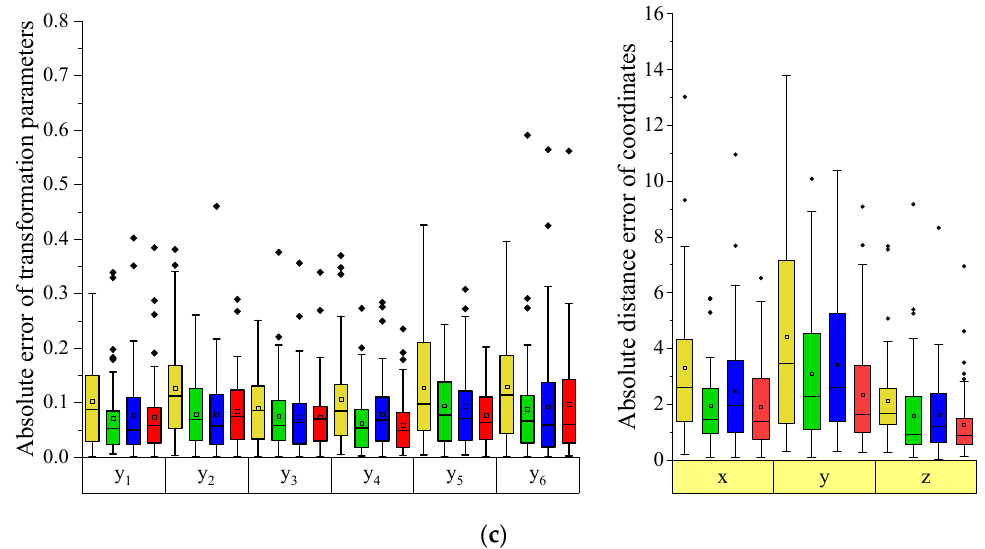
Figure 3. Box plot for the absolute difference of 6 transformation parameters, and coordinates for ( a ) part 2, ( b ) part 3, and ( c ) part 4. Yellow, green, blue, and red colors of the graph are error of network using pointnet, pointconv, pointnet++, and present method.